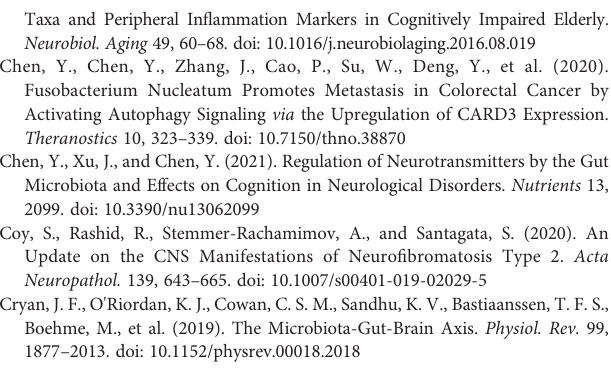
Supplementary Figure 1 | Heat map of the relative abundances of the top 60 dominant taxa at genus level in all samples. The genera were displayed from higher abundance (in red) to lower abundance (in